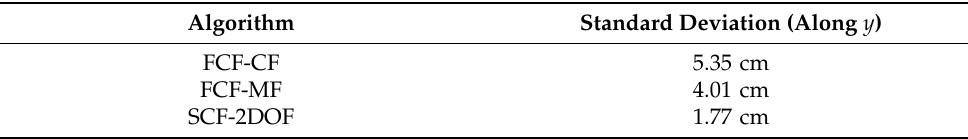
Figure 14. Comparison between the algorithms FCF-CF, FCF-MF and SCF-MF-2DOF for the esti- mation of the drone position along the altitude axis y . It can be observed that, if the SCF-MF-2DOF algorithm is used, the difference between the altitude estimates and the desired altitude profile ( p y = 0) is of an order of magnitude smaller than the other two analyzed methods. Table 1. Standard deviation of the altitude position error for different algorithms.